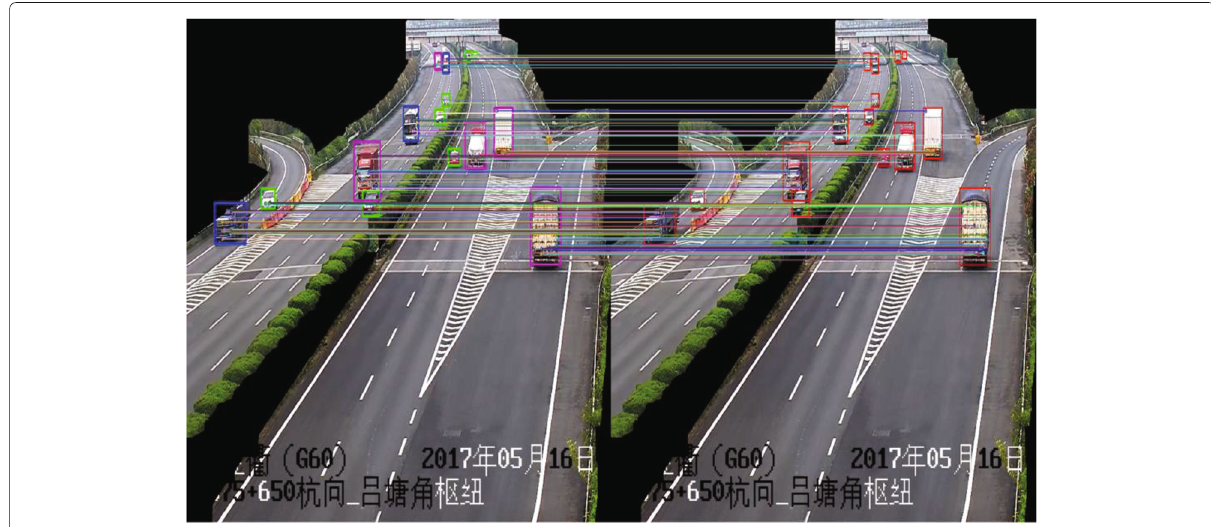
Fig. 11 Features of the detection object extracted by the ORB algorithm